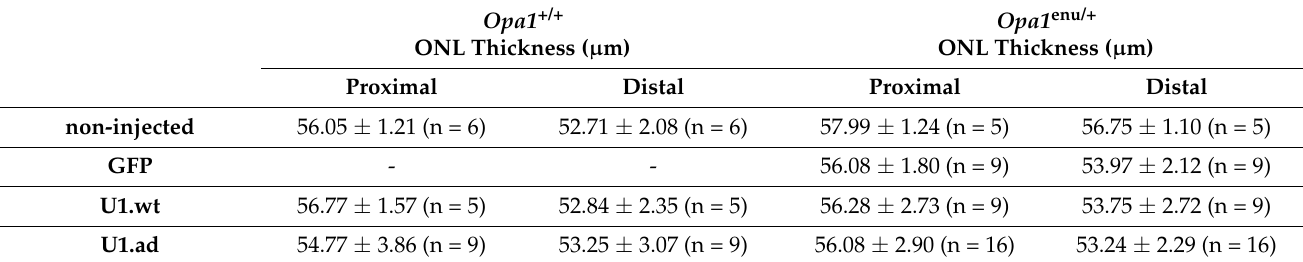
Table 1. ONL thickness of the central retina is not altered by the U1 treatments. The average outer nuclear layer (ONL) thickness in micro-meters ( µ m) is listed with standard deviations. Retinae from Opa1 +/+ (wild-type) and Opa1 enu/+ (heterozygous mutant) animals are compared. ONL thickness was measured at regions proximal and distal to the optic nerve head. Pairwise comparison of ONL thickness at proximal and distal regions between groups using Mann-Whitney U test with Bonferroni correction did not yield significant differences (Supplementary Table S2). The number of biological replicates is indicated in brackets (n = 5–16). Opa1